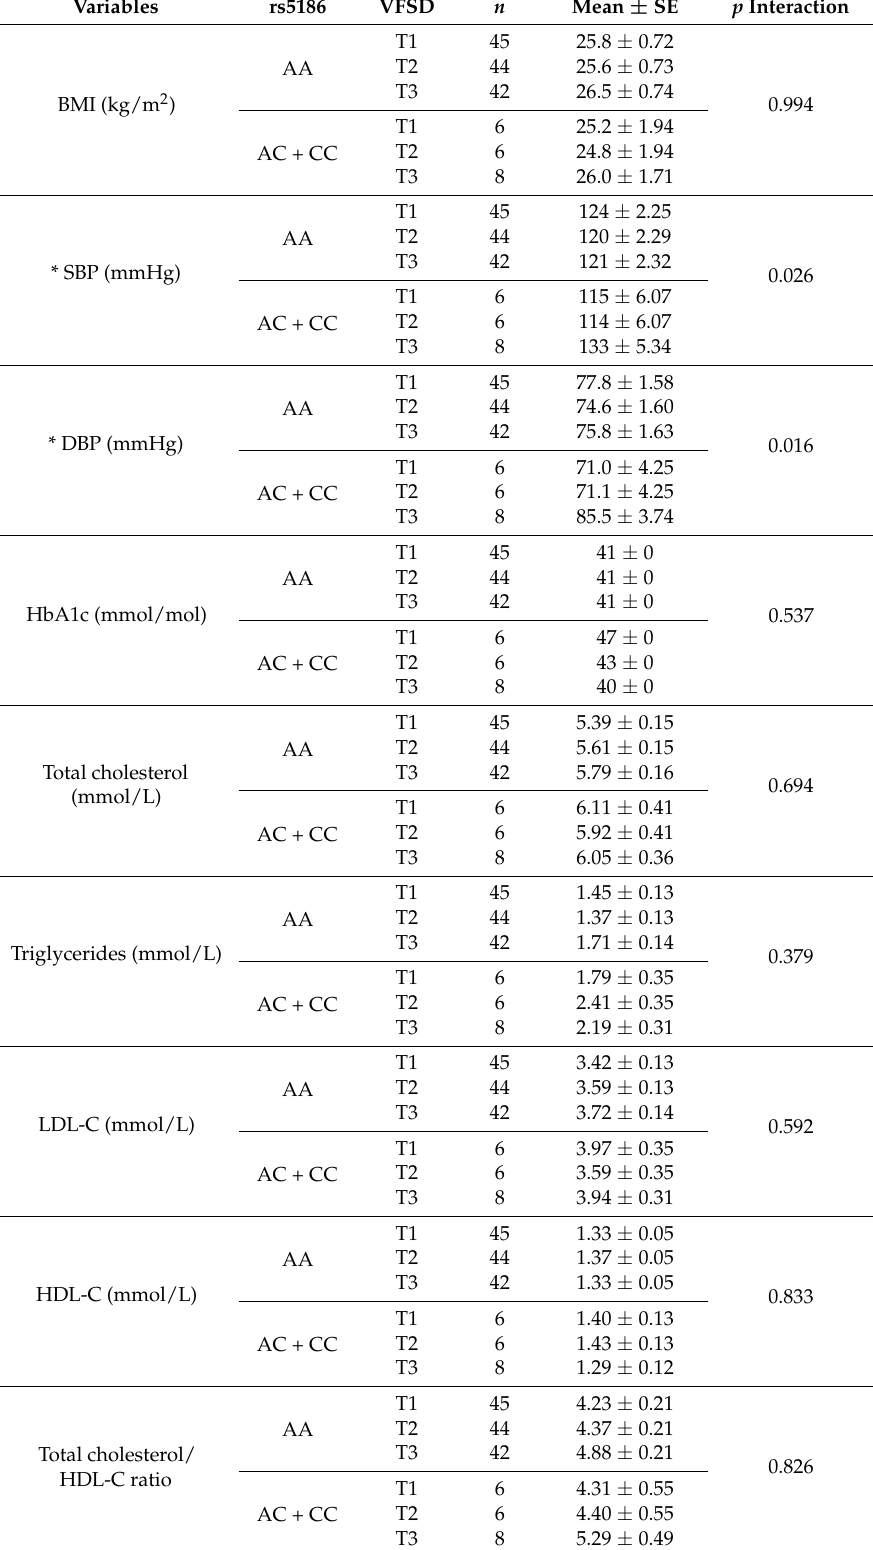
Table 5. Interaction between tertiles of “vegetables, fruits, and soy diet” (VFSD) and genotypes of the AGTR1 gene rs5186 SNP on metabolic risk factors of CVD in Malay